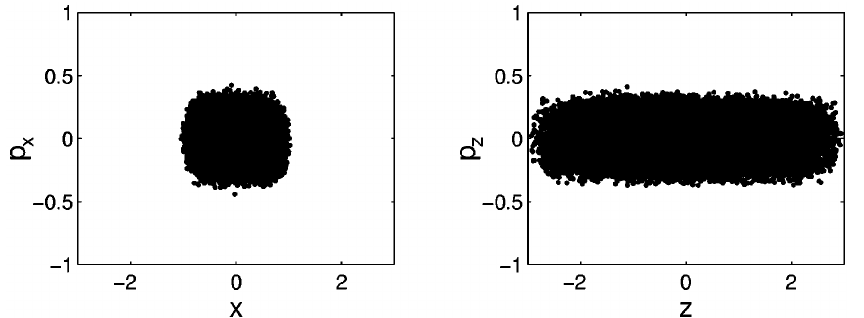
FIG. 2. Longitudinal phase space diagram at (cid:116) (cid:173) (cid:57)(cid:48)(cid:48) of initially matched beam m (cid:120) (cid:173) m (cid:121) (cid:173) m (cid:122) (cid:173) (cid:49)(cid:46)(cid:48) for the 6D stationary distribution with 32 768 particles plotted ( (cid:99) (cid:121) (cid:97) (cid:173) (cid:51)(cid:44) h (cid:120) (cid:173) (cid:48)(cid:46)(cid:51)(cid:53)(cid:44) h (cid:122) (cid:173) (cid:48)(cid:46)(cid:50)(cid:53) ). 014201-3